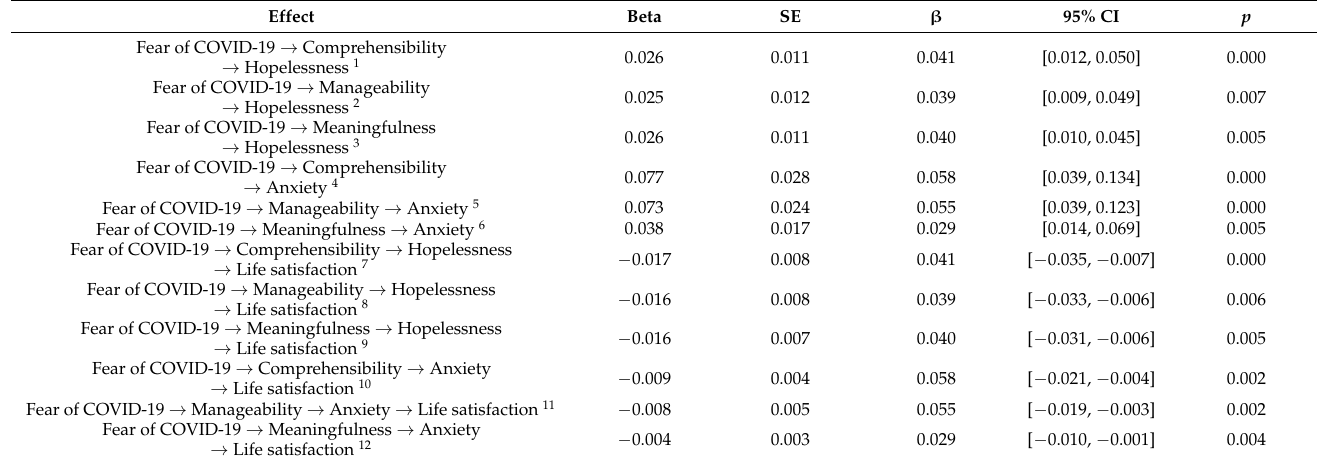
Table 3. Indirect effects of fear of COVID-19 on hopelessness, anxiety, and life